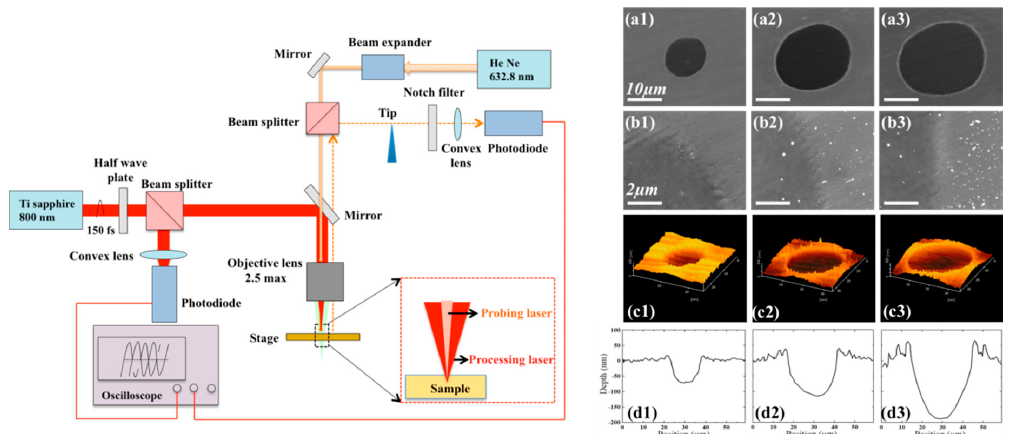
Figure 1. The left image, pump-probing setup of femtosecond laser-induced in As 2 S 3 , and the fullwidthathalfmaximum (FWHM) of pump laser and probing laser are 36 μ m and 20 μ m, respectively. ( a1 )–( a3 ) The right image, scanning electron microscopy; ( b1 )–( b3 ) the magnified SEM images; ( c1 )–( c3 ) AFM images; ( d1 )–( d3 ) and the cross-sections AFM images. Irradiation laser flences: 8.26 mJ/cm 2 , 18.58 mJ/cm 2 and 30.98 mJ/cm 2 ,